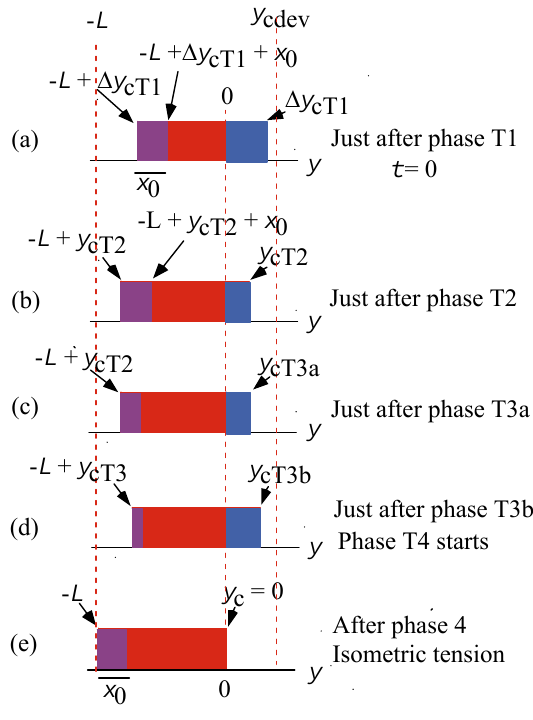
Figure 11. Changes of the  distribution during the isometric tension transient in the case of  y < y . Magnitude of y is exaggerated for cT1 cdev cdev